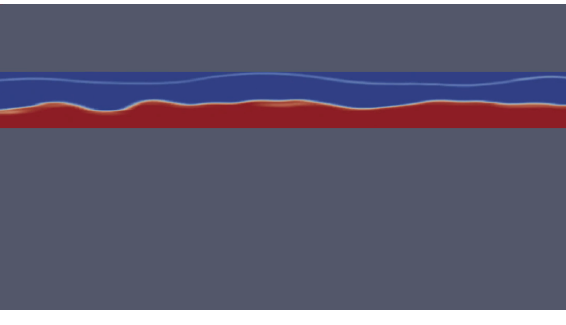
Figure 7. Wavy flow pattern.